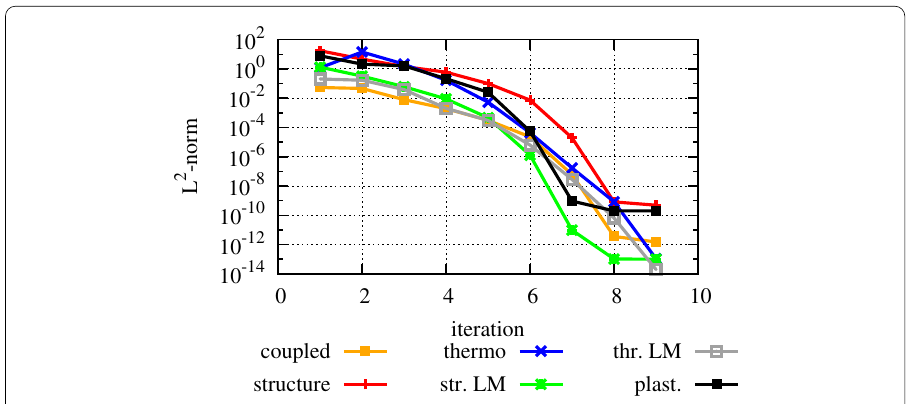
Fig. 11 Squeezed elasto-plastic tube—convergence of different residuals in Newton’s method for t = 0 .